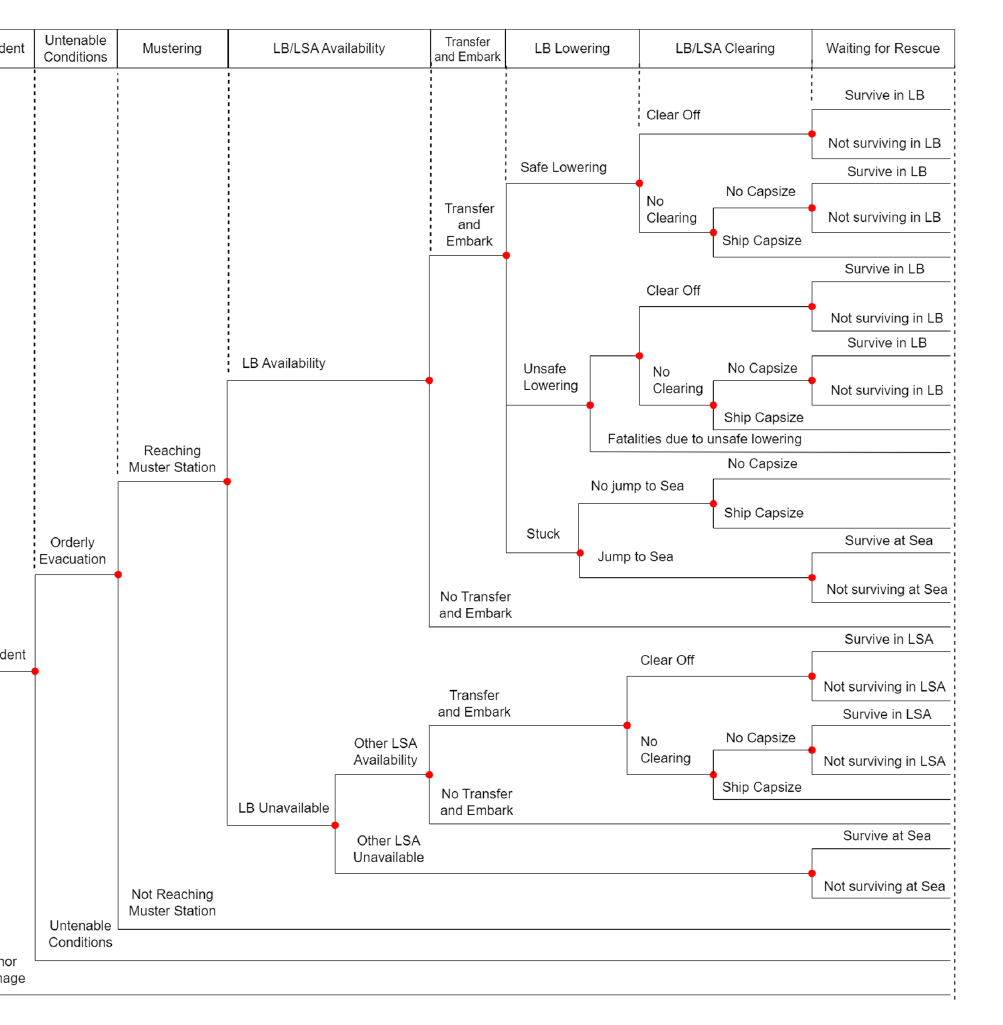
Figure 3. Event tree for flooding accidents.